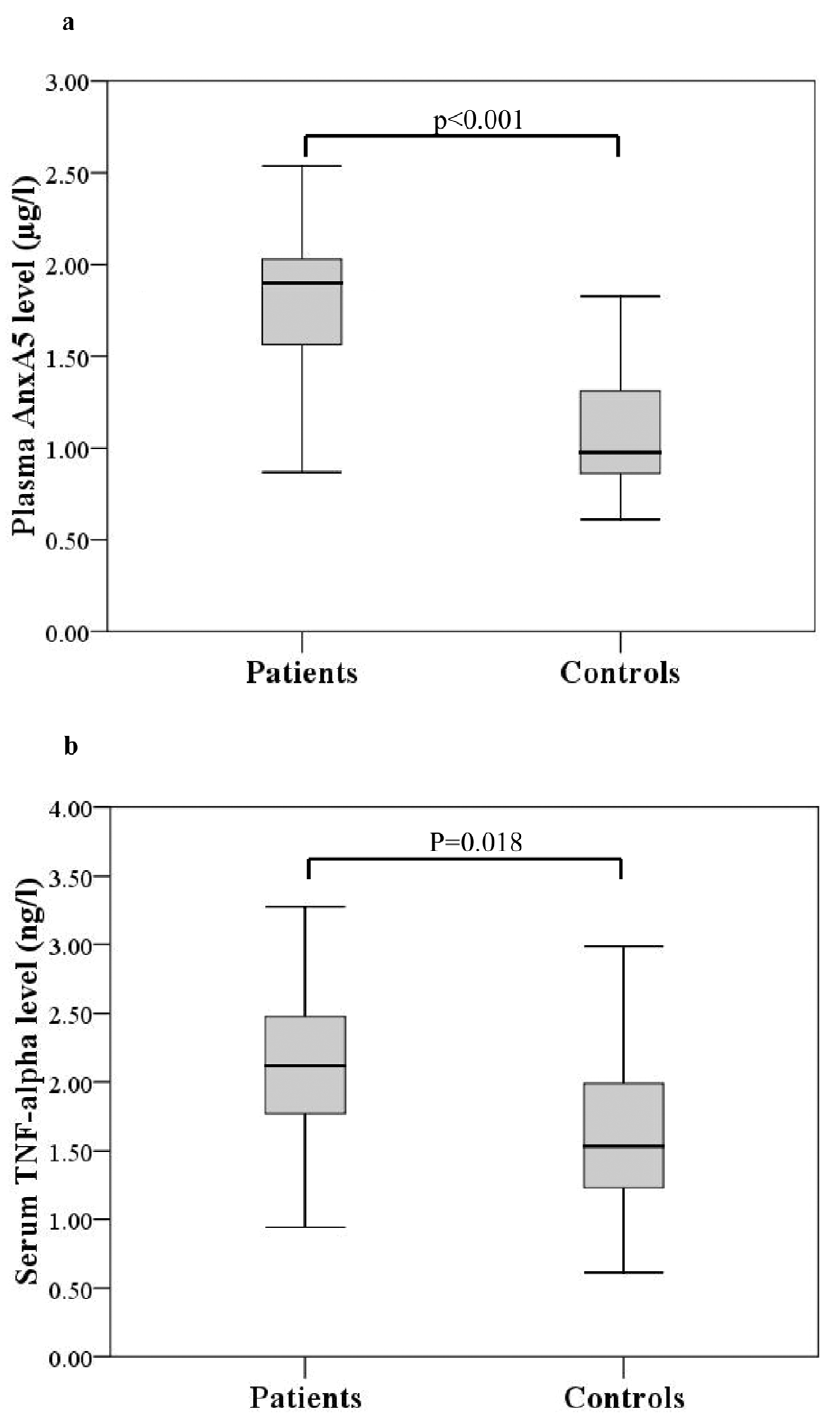
Figure 1. Box-plots showing (a) plasma annexin A5 (AnxA5) levels and (b) serum tumour necrosis-factor (TNF)- a levels in patients and controls.